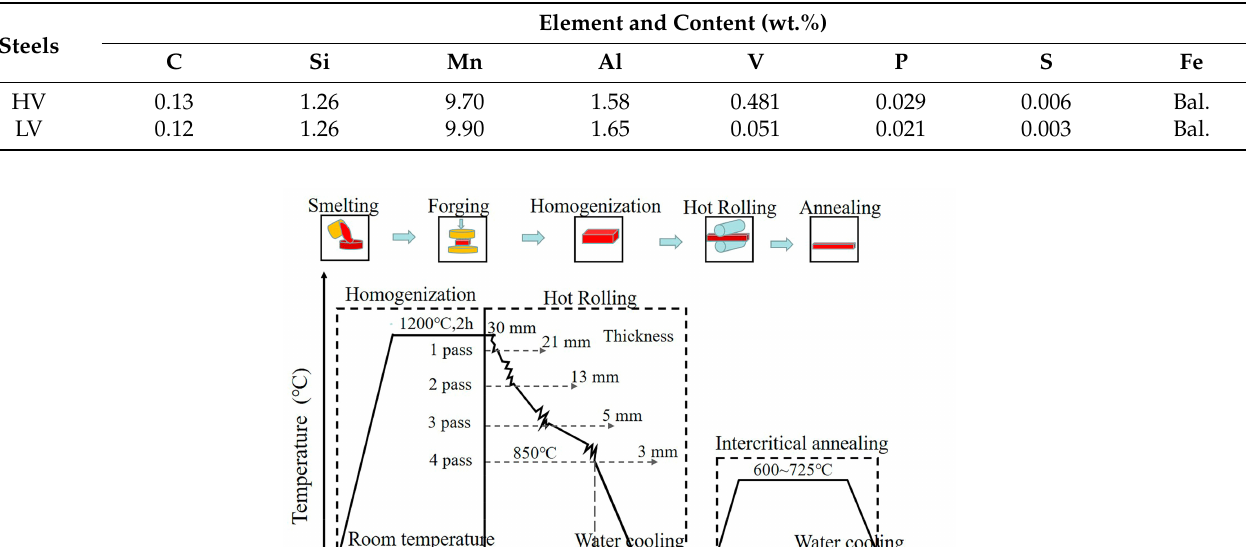
Table 1. The analyzed chemical compositions of the present steels. Element and Content (wt.%) Steels